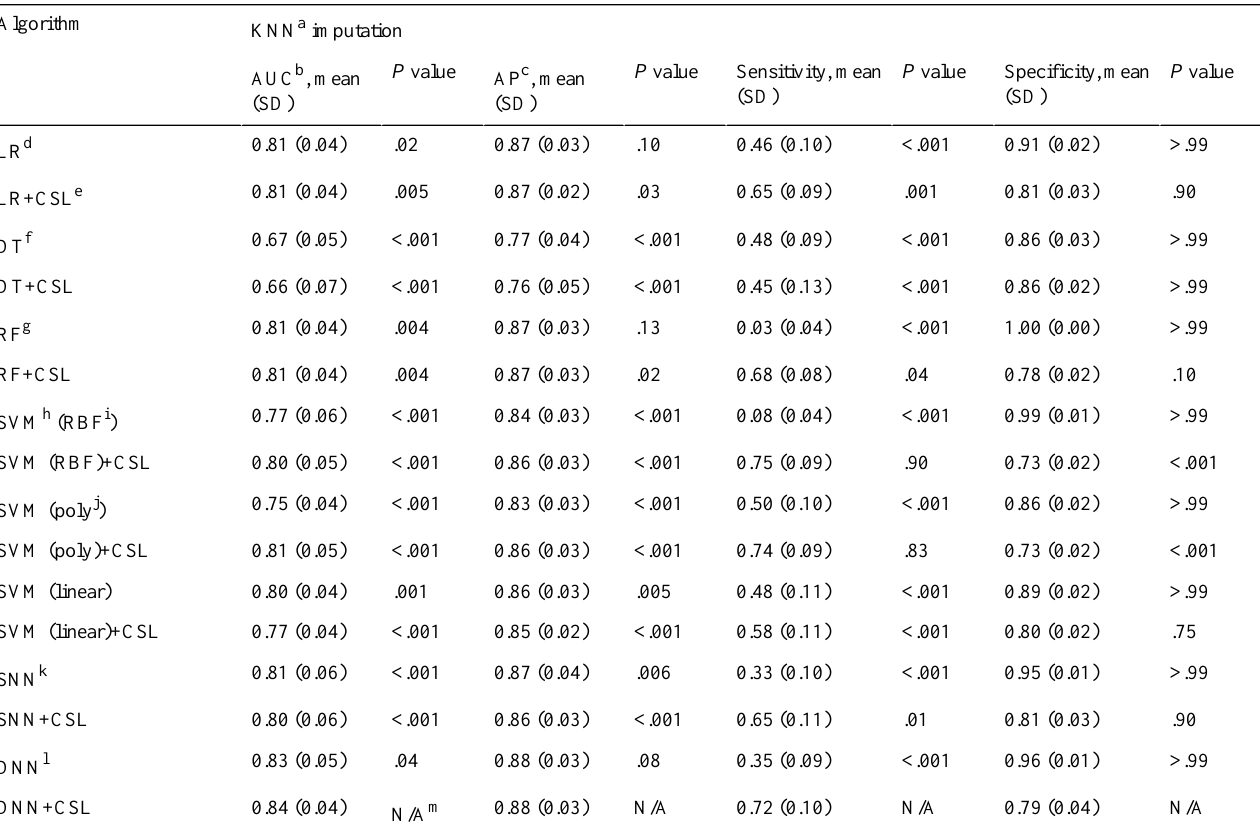
Table 3. Performance of algorithms with missing data handled by k-nearest neighbor